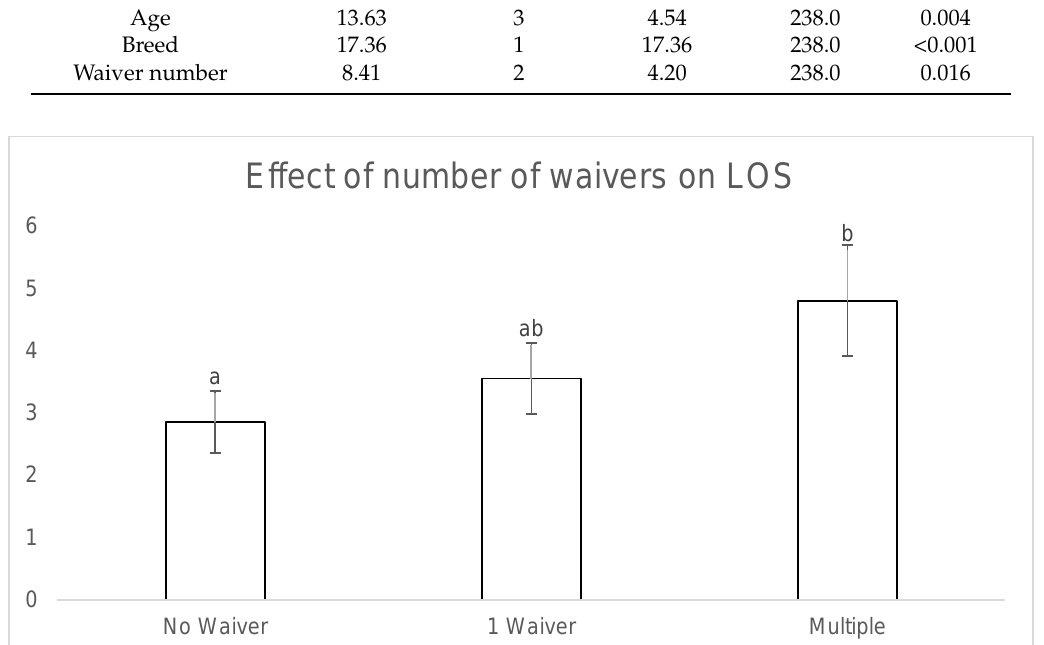
Figure 2. Effect of waiver number on LOS.